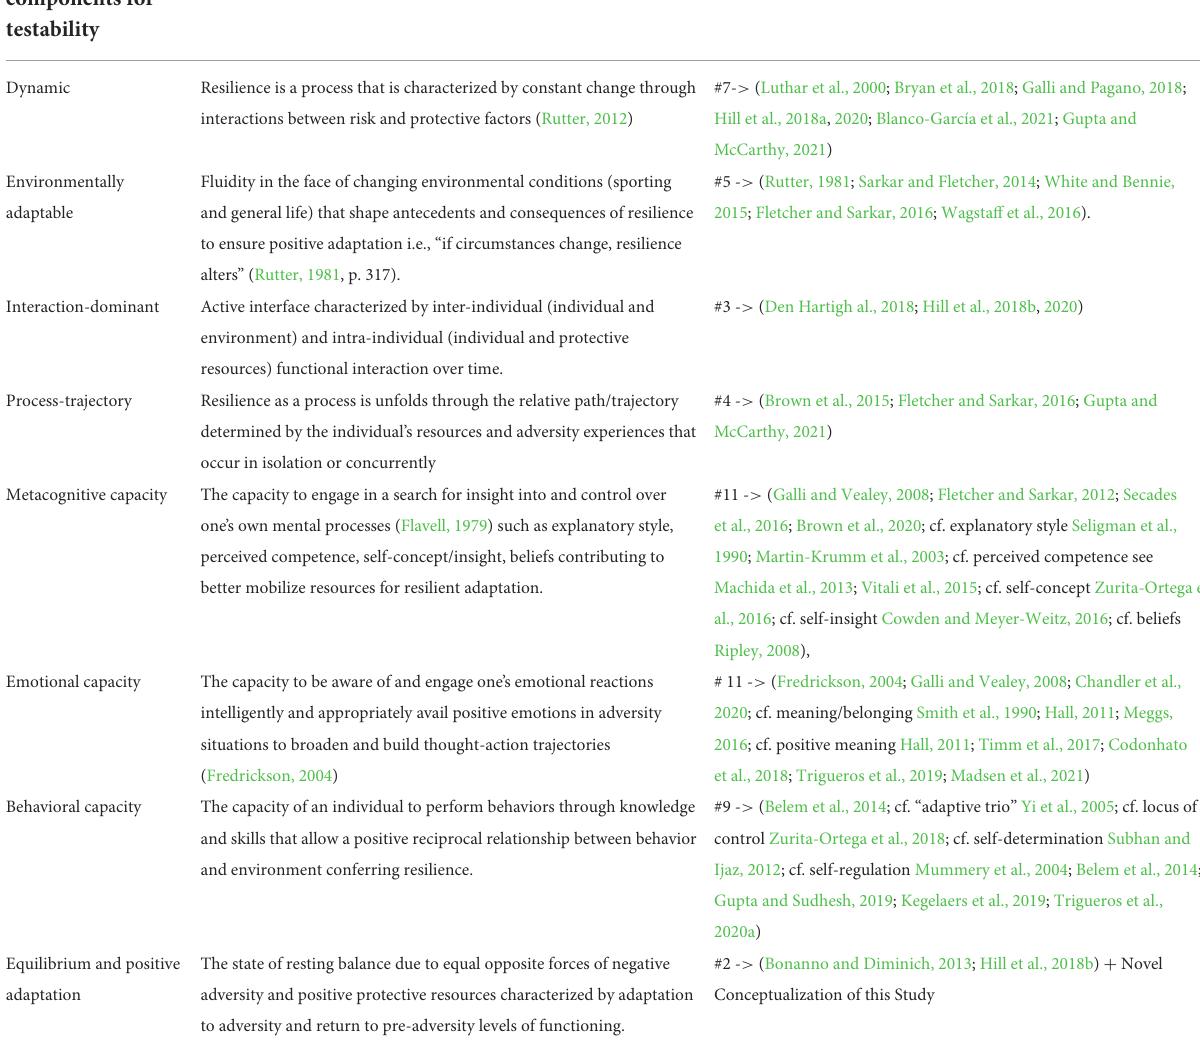
TABLE 1 Definitional clarity and empirical evidence of components of “sporting